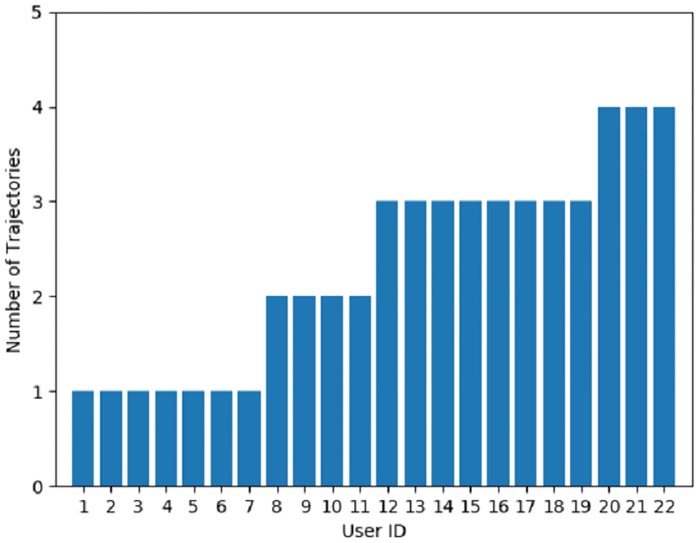
Trajectory distribution of 22 users filtered.